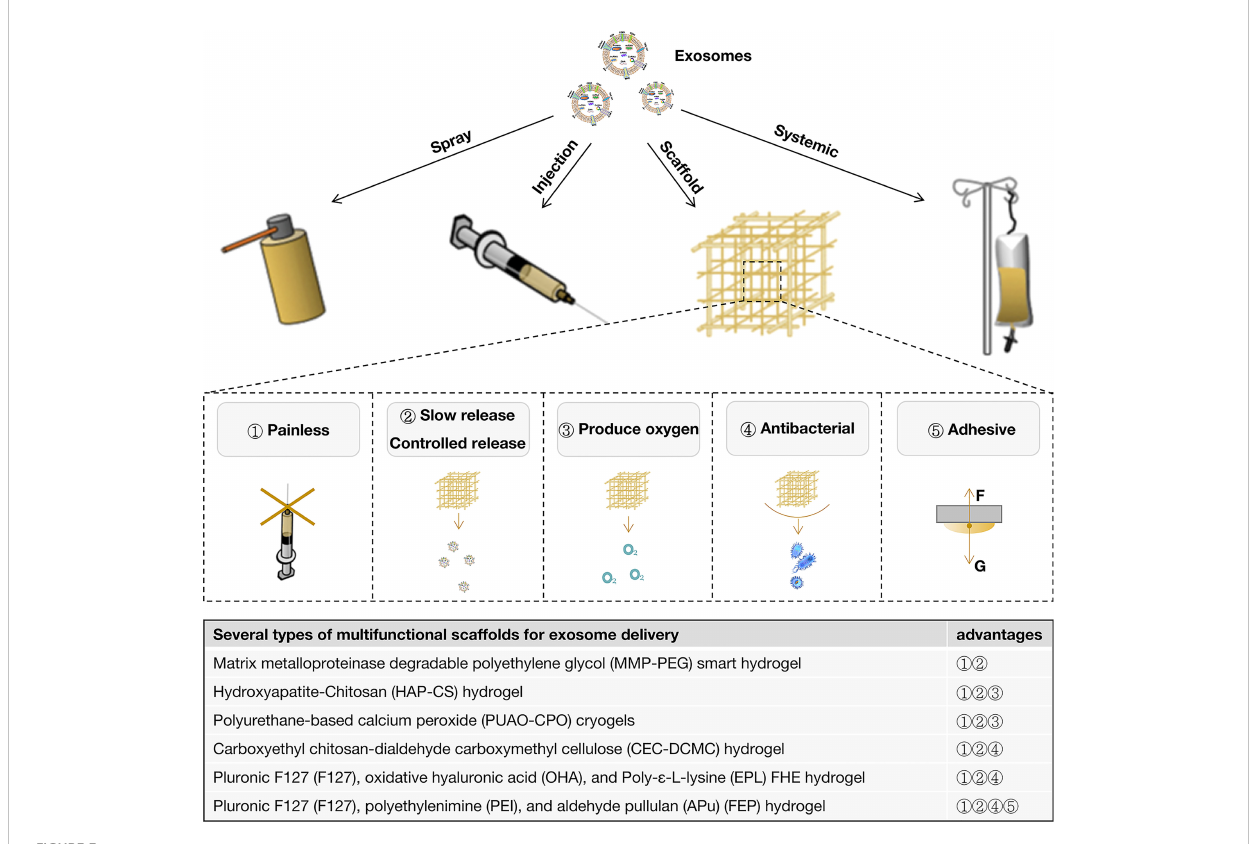
FIGURE 3 Exosome delivery methods for diabetic wounds and the advantages of